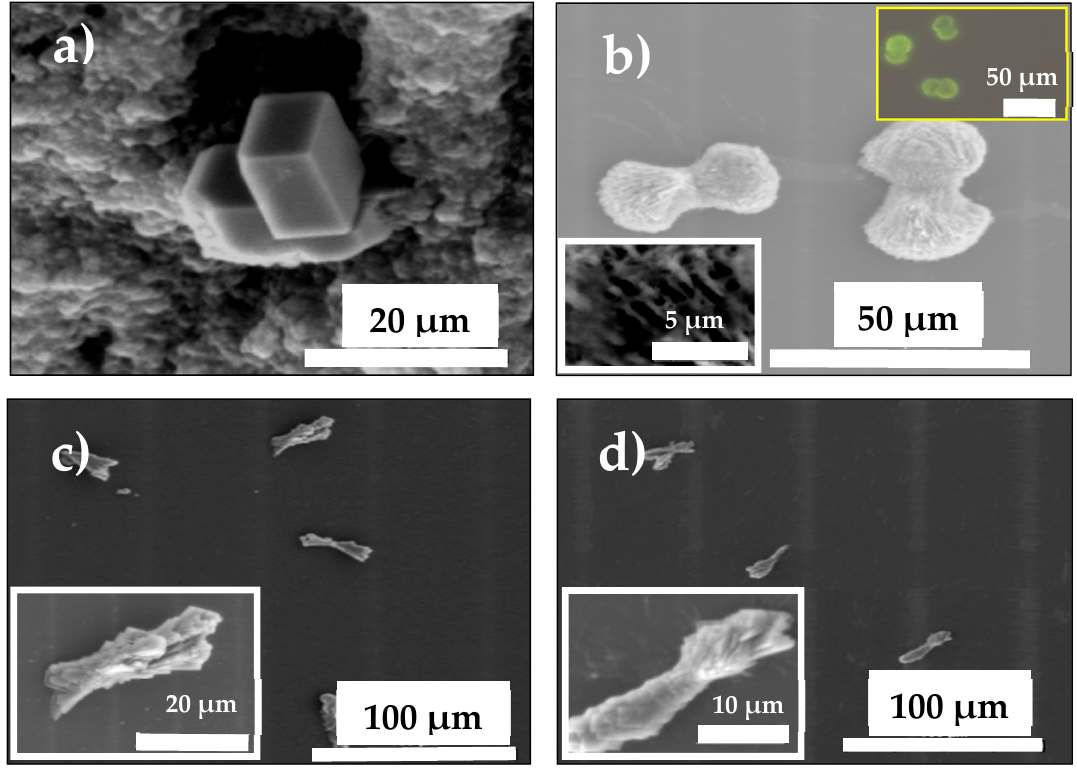
Figure 2. SEM images of CaCO 3 crystals grown in the presence of MWCNTs: ( a ) MWCNT, ( b ) MWCNT-Ox, ( c ) MWCNT-IA, and ( d ) MWCNT-MMI. Inset in Figure 2b shows an optical image of fluorescent aragonite labeled with 5-FTSC .